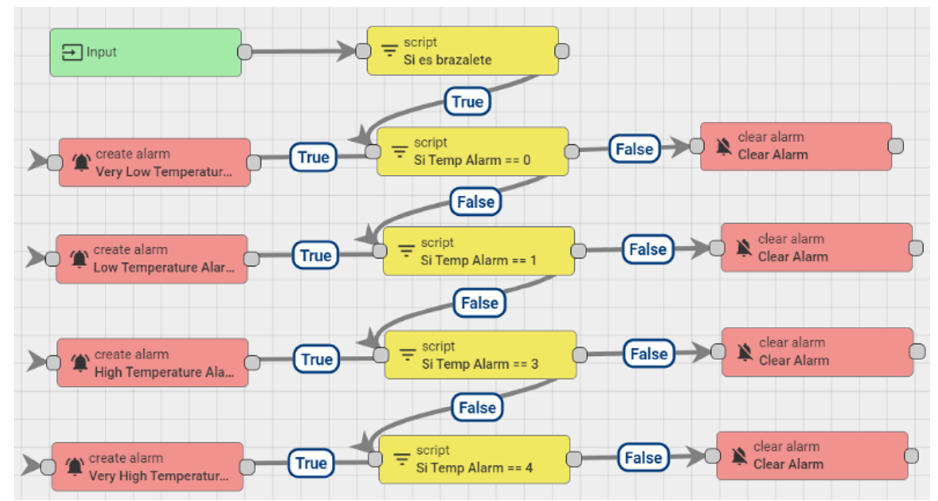
Figure 13. System of alarm rules established in